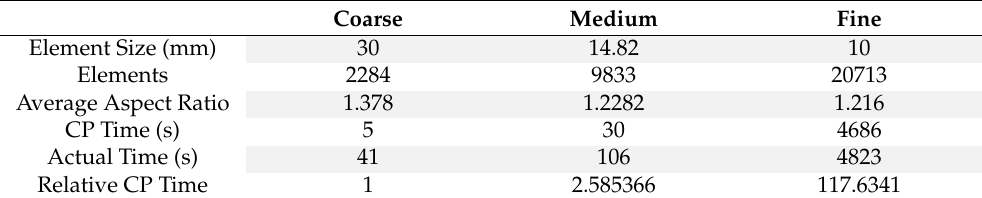
Table 12. Mesh information.